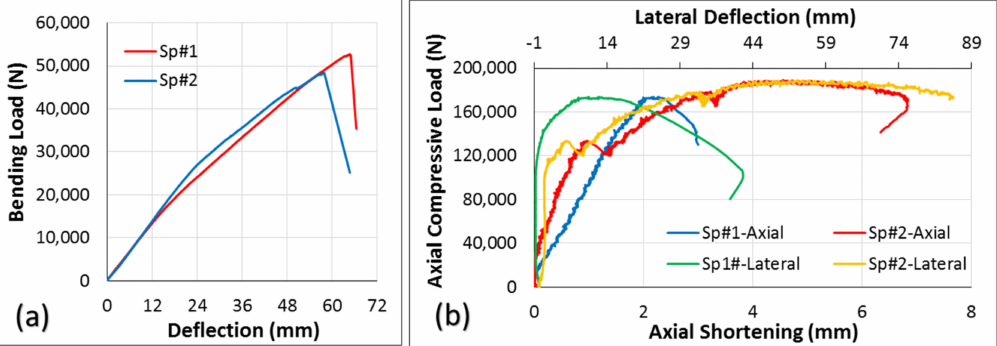
Figure 10. Load-deflection curves for two-layered core sandwich panels under ( a ) bending and ( b ) axial compression tests.